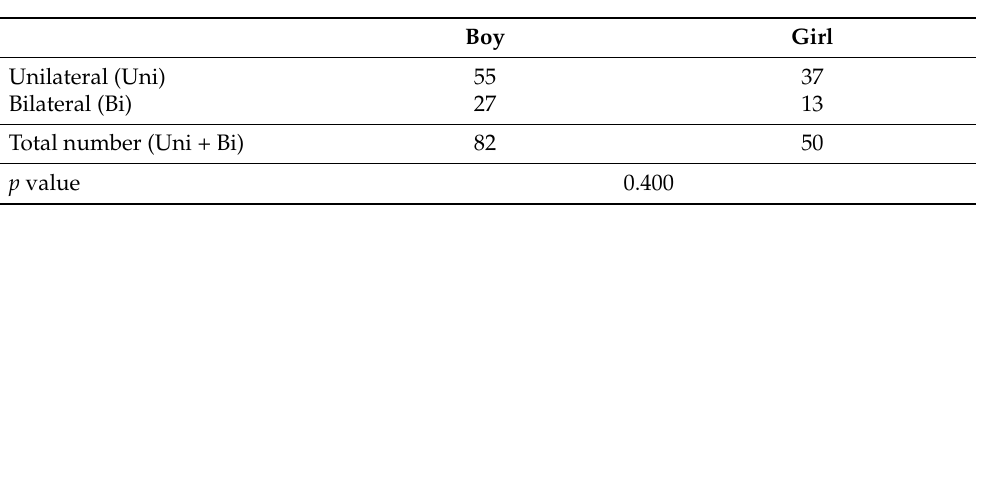
Table 3. Distribution of gender and relationship between gender and the number of affected